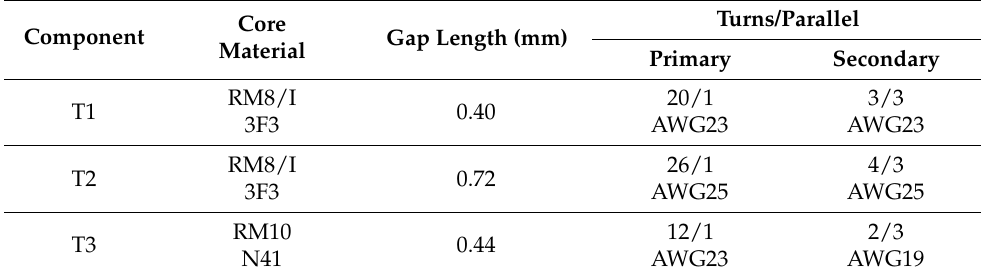
Table 2. Characteristics of the measured